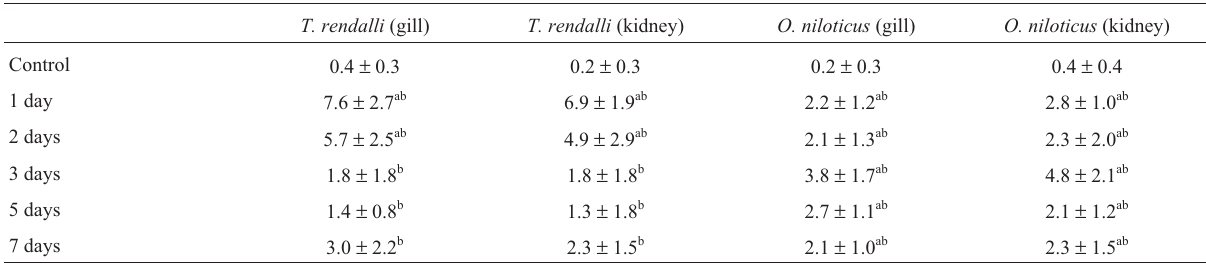
Table II - Mean ( ± S.E.) micronucleus frequencies (MN/1,000 erythrocytes) in fish treated with mitomycin